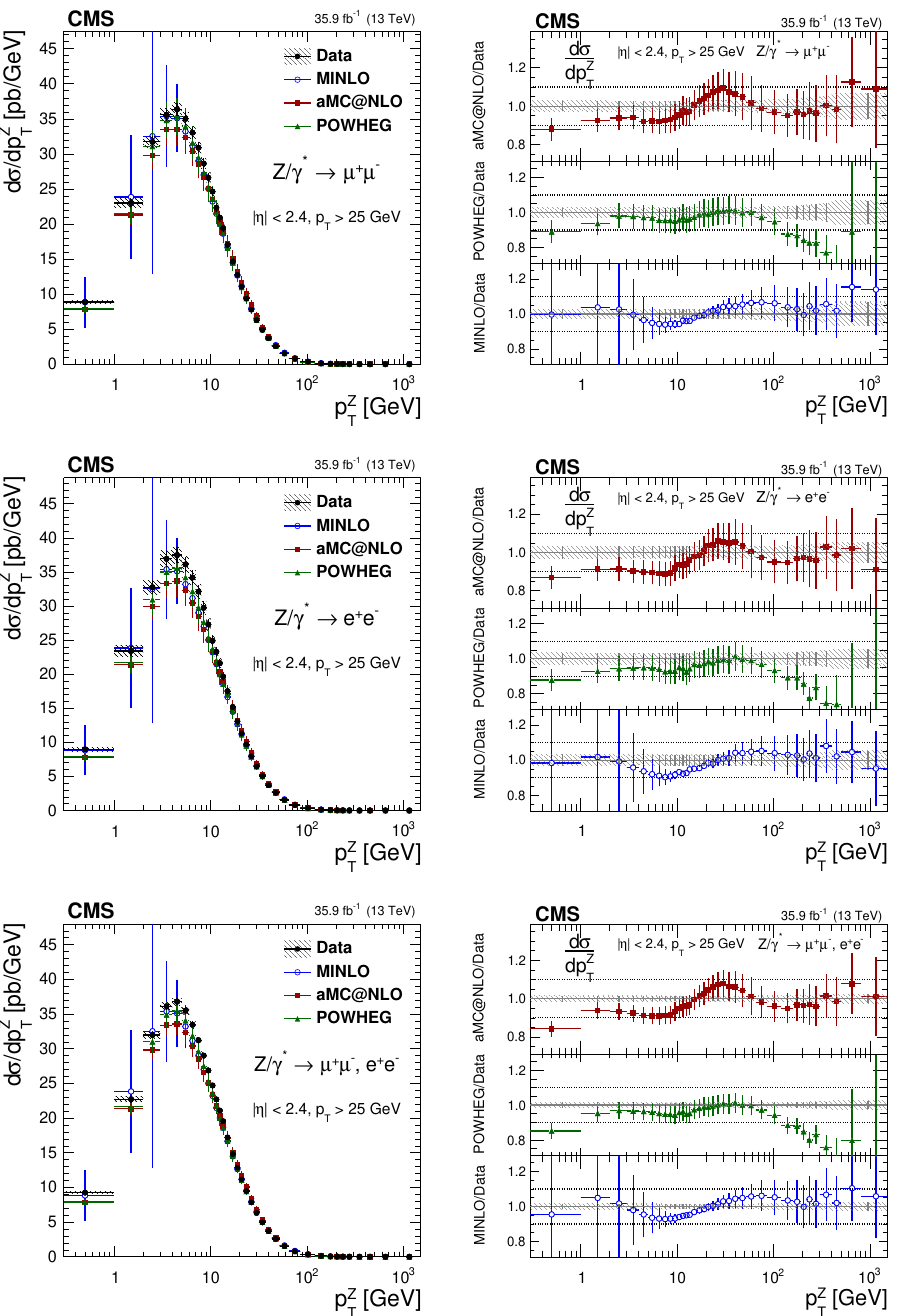
Figure 6 . The measured absolute cross sections (left) in bins of p Z dielectron (middle) (cid:12)nal states, and for the combination (lower). The ratios of the predictions to the data are also shown (right). The shaded bands around the data points (black) correspond to the total experimental uncertainty. The measurement is compared to the predictions with Mad- Graph 5 a mc@nlo (square red markers), powheg (green triangles), and powheg - MINLO (blue circles). The error bars around the predictions correspond to the combined statistical, PDF, and scale uncertainties.